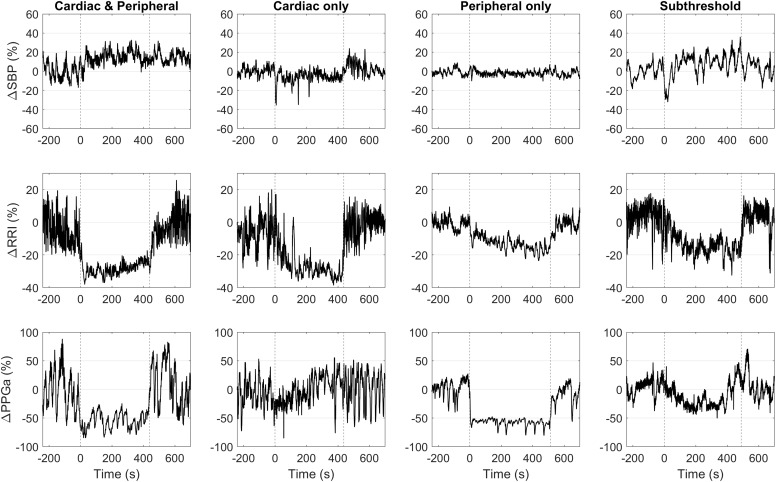
Representative data of four subjects with different HUT response phenotypes. Vertical dashed lines mark the onset and the end of HUT.